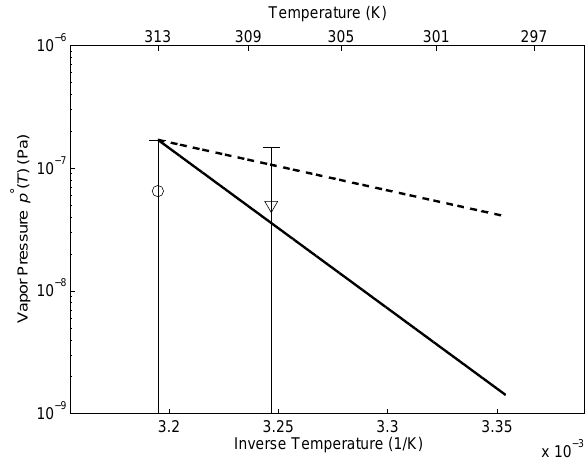
Fig. 6. Pure component vapor pressure p ◦ ,L of DL-tartaric acid (open symbols, denoting two different particles). The measurement at ∼ 312K is indistinguishable from zero. The upper and lower limit of vapor pressure at T ≈ 305K is extrapolated to T (cid:9) using 1H (cid:9) vap of 75 (dashed) or 250 (solid)kJmol − 1 and Eq. (5). The largest pos- sible range of vapor pressure at T (cid:9) from this extrapolation is re- ported.